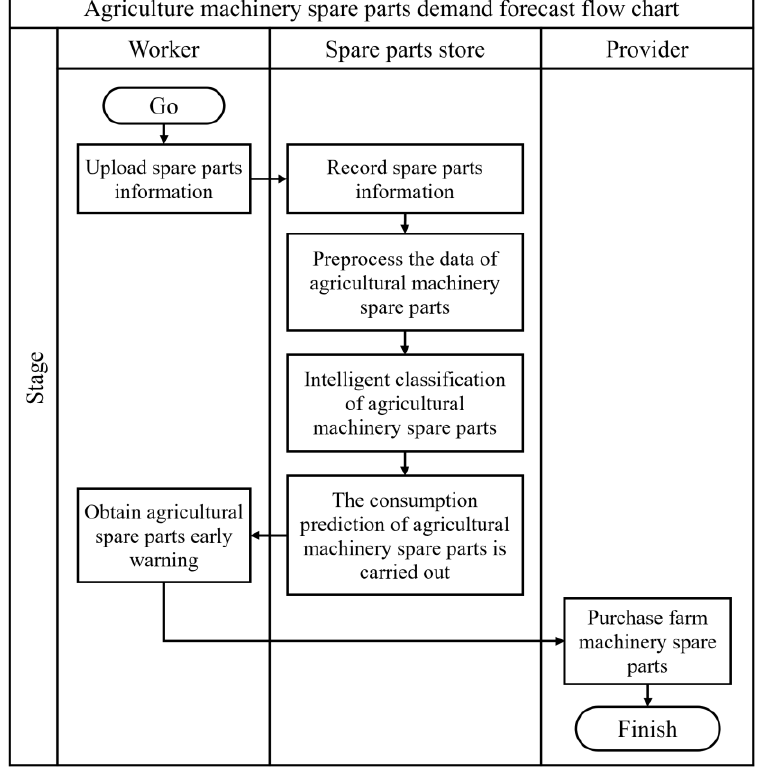
Figure 1. Agricultural machine spare parts demand prediction flowchart.